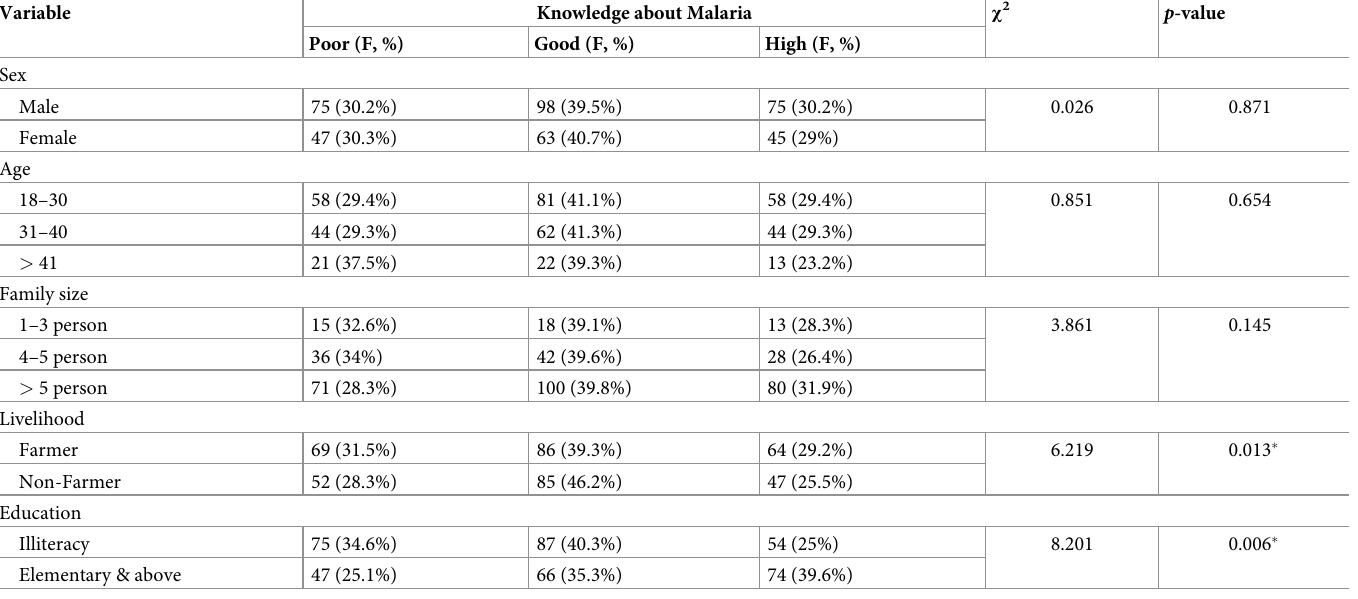
Table 5. Association of knowledge about malaria with selected socio-demographic